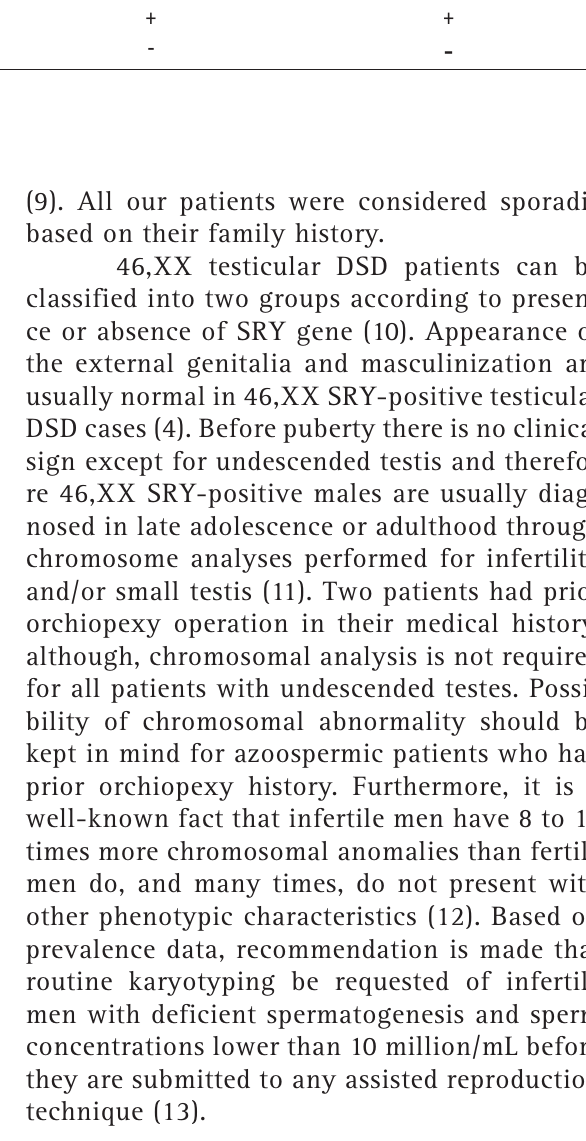
figure 1 - presumable Ideogram of chromosomes.